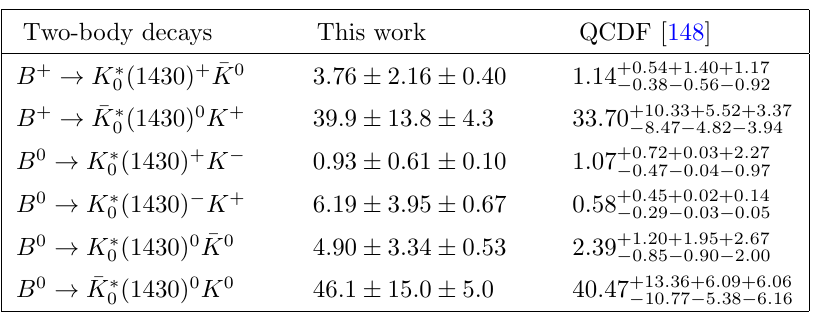
Table 7 . Comparison of the extracted predictions with the QCDF results in [148] for the relevant two-body branching fractions (in units of 10 (cid:0) 7 ). The sources of the errors of our results are the same as in table 4. Decay modes This work Theory ref.